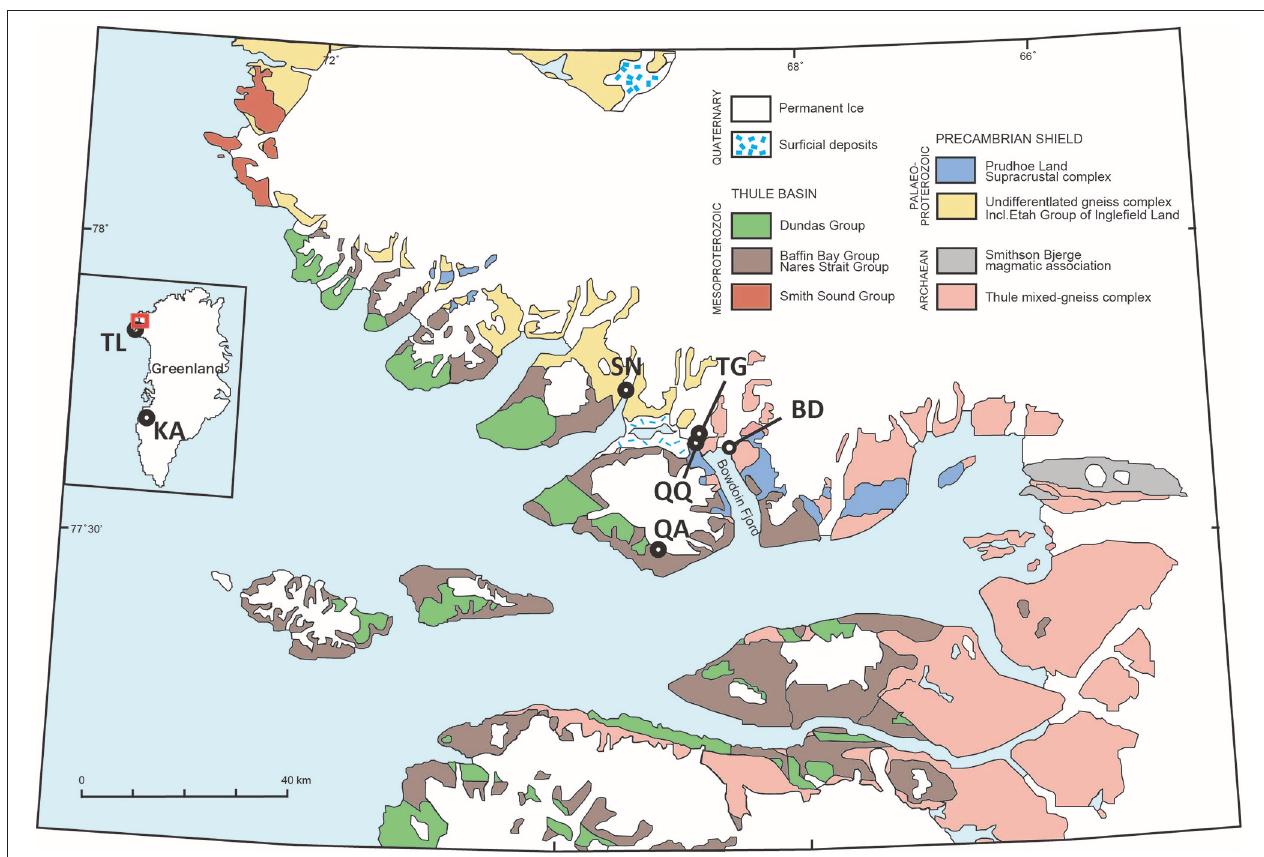
FIGURE 1 | Geological map of northwestern Greenland modified from Thomassen et al. (2002) showing the glaciers where cryoconite samples were collected. (QA, Qaanaaq Glacier; QQ, Qaqortaq Glacier; TG, Tugto Glacier; BD, Bowdoin Glacier; SN, Sun Glacier; TL, Thule Ramp; KA, Kangerlussuaq area included Russell and Isunnguata Sermia